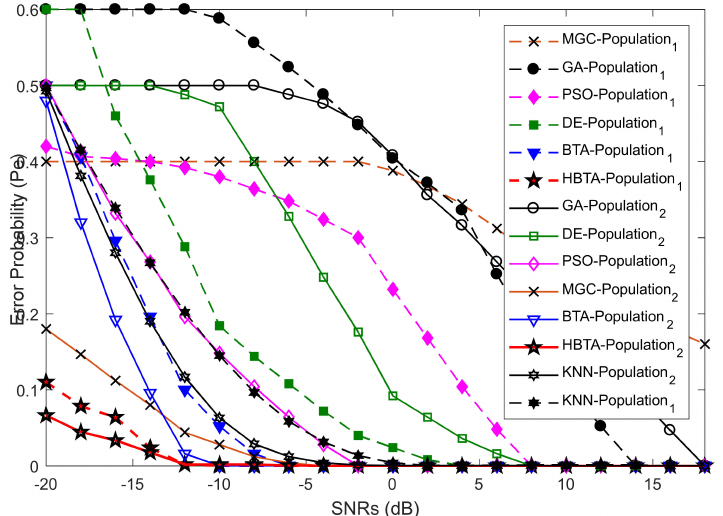
Figure 17. Error probability vs. SNRs in the presence of AN-ANC users with population 1 (30) and population 2